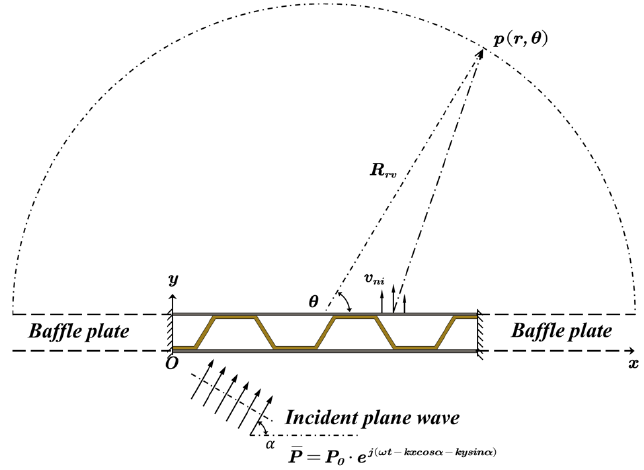
Figure 9. Sound transmission through the sandwich panel.